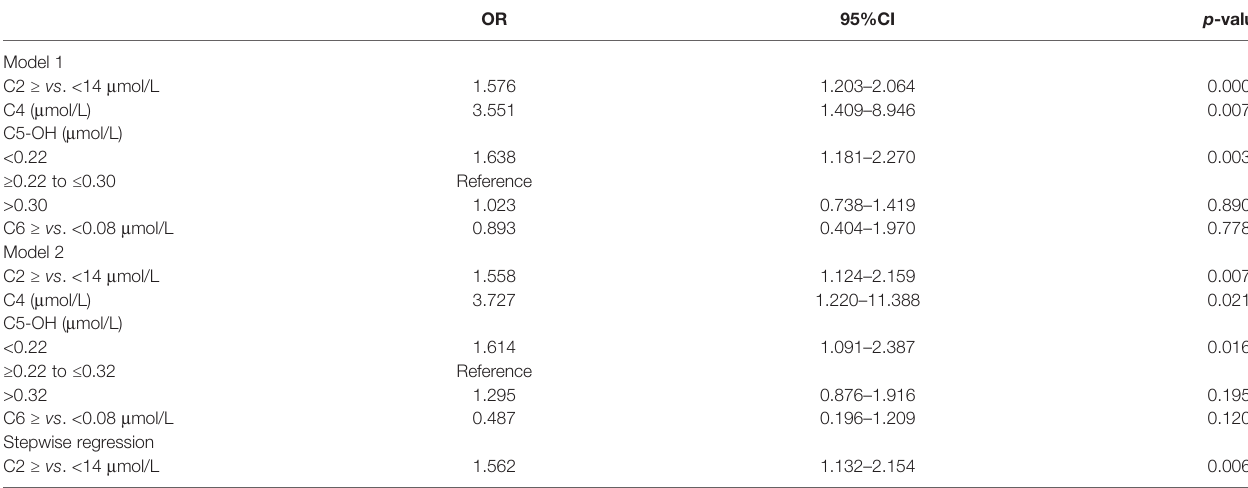
TABLE 3 | Odds ratios of short-chain acylcarnitine for CVD risk in T2DM. OR